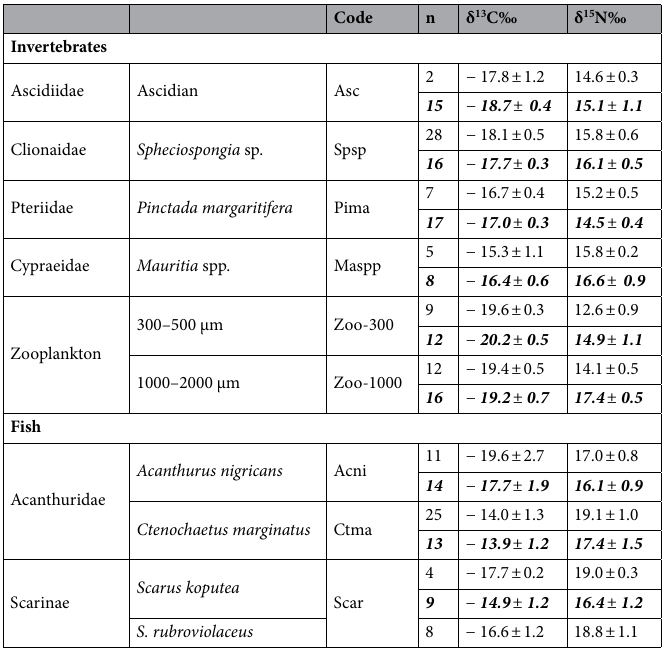
Table S3). Other sampled consumer species not included in Fig. 3 for clarity fitted well within this network based on their δ 13 C and δ 15 N values (Suppl. Table S3). On average, the mean δ 15 N value of Sr-AA (phenylalanine and glycine) was 11.6 ± 3.4‰ with values ranging from 7.1‰ for glycine in Lutjanus bohar to 17.0‰ for phenylalanine in Conus conco (Table 2). Differences in Sr-AA δ 15 N values among species were more evident for glycine than for phenylalanine.